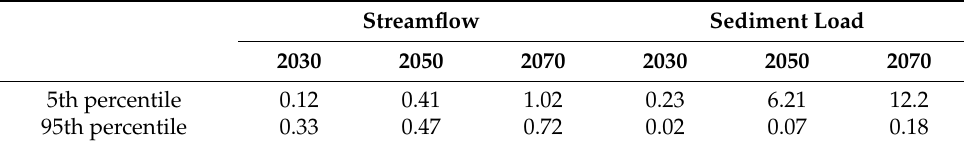
Table 5. Percentage changes in monthly streamflow and sediment load at the 5th and 95th percentiles under the influences of changing LUC scenarios.